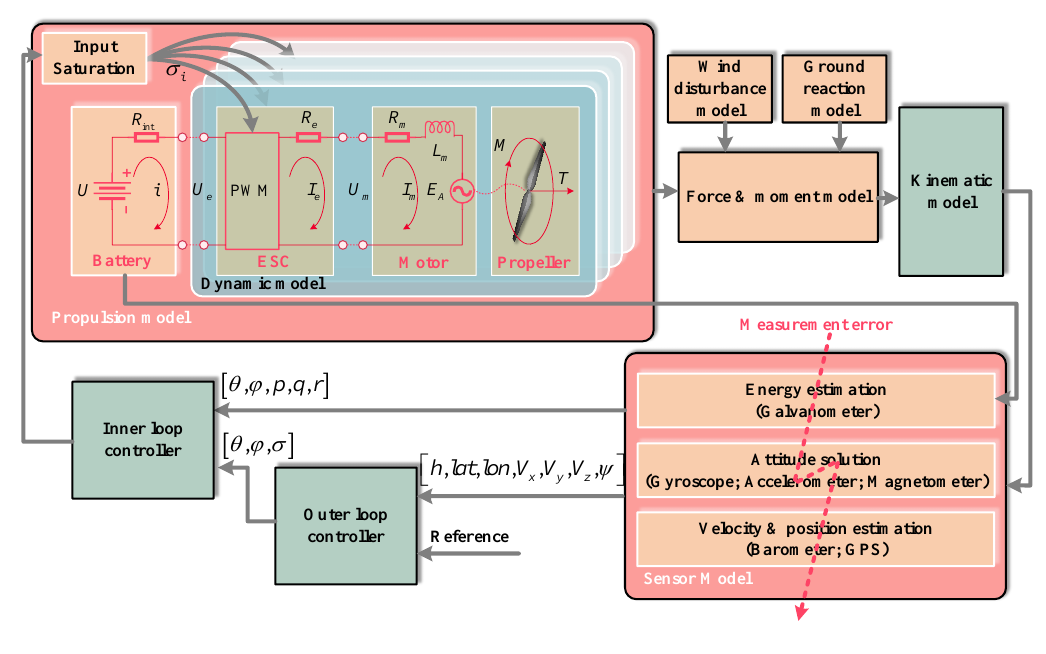
Figure 2. Structure of the simulation model for the QUAV autopilot